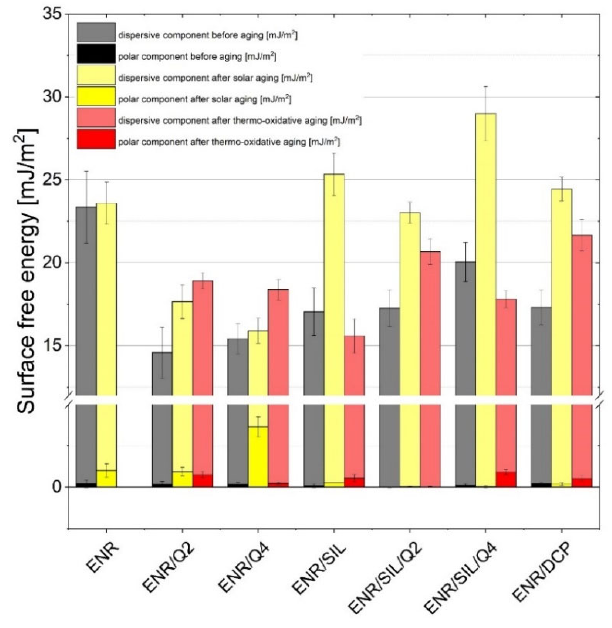
Figure 4. Surface energy results of ENR ‐ 50 ‐ based composites before and after aging processes.